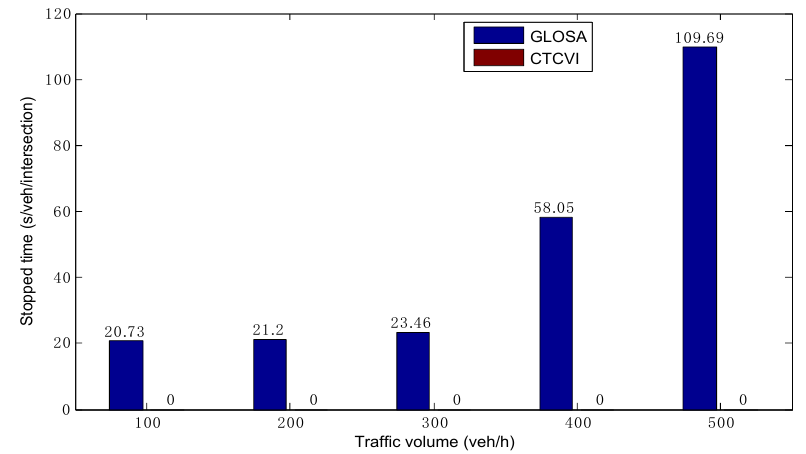
Figure 8. Comparison of average stopped time before the intersection.